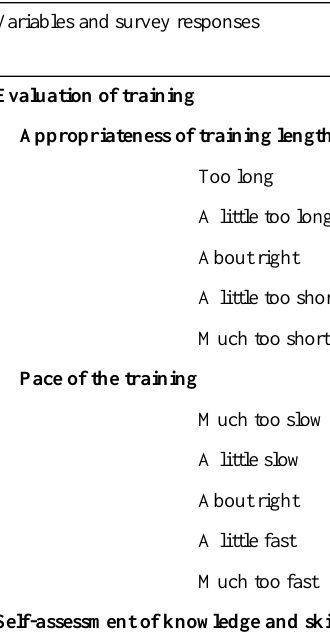
Table 2. Comparison between Second Life training and CDC a face-to-face